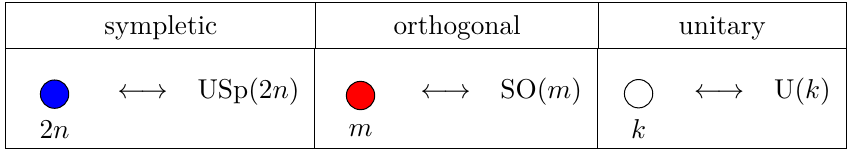
Table 4. Colored nodes used in the